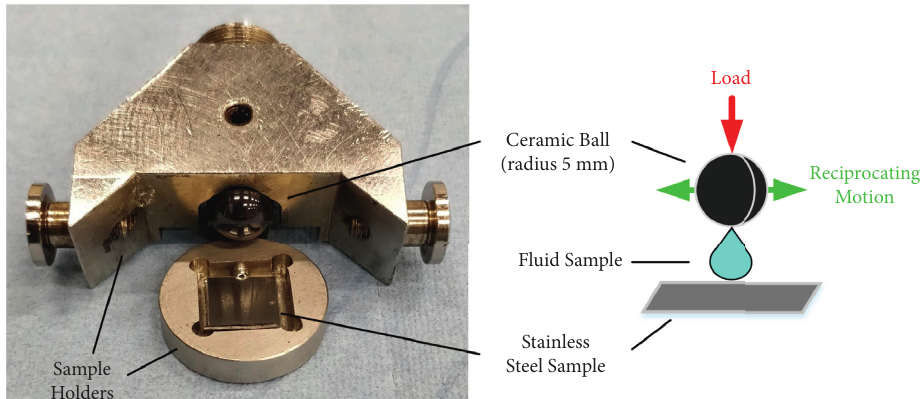
Figure 2: Setup of tribological experiment showing ceramic ball and stainless-steel plate in their respective sample